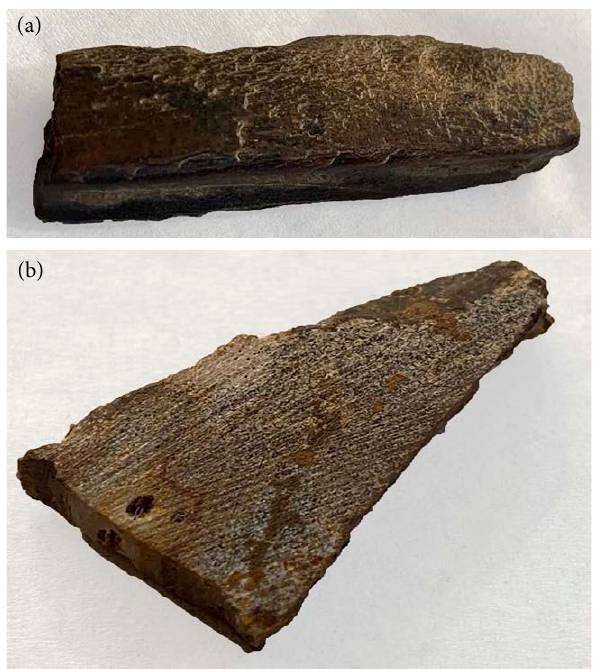
Fig. 1. Sections of Bombacoxylon owenii (a) and Dalbergioxylon dicorynioides